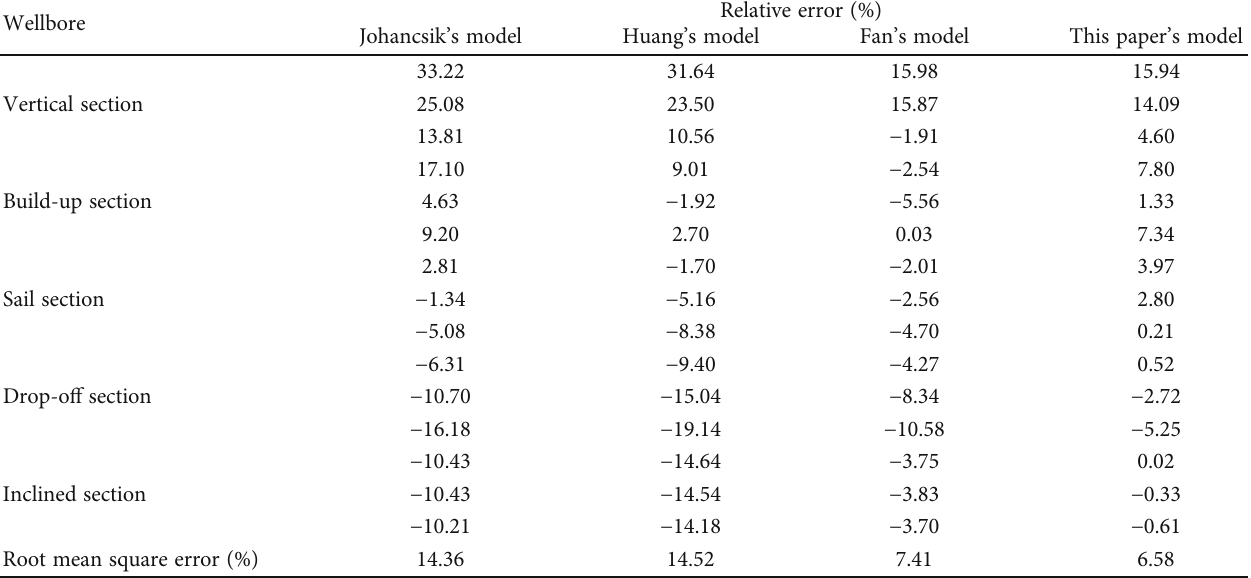
Table 3: Comparison of model prediction